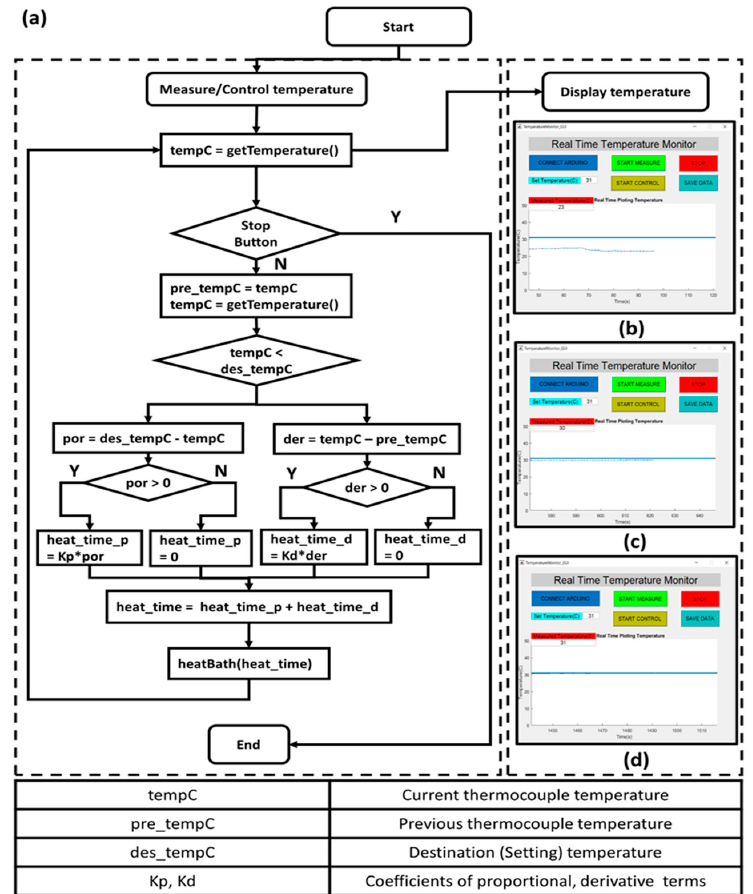
Figure 2. The PID control flowchart for controlling the bath temperature: ( a ) The flowchart shows the measurement and control procedure for the bath temperature; ( b – d ) shows the “Real Time Temperature Monitor” GUI captured at three different time points. The temperature increases gradually and stabilizes at the target temperature.